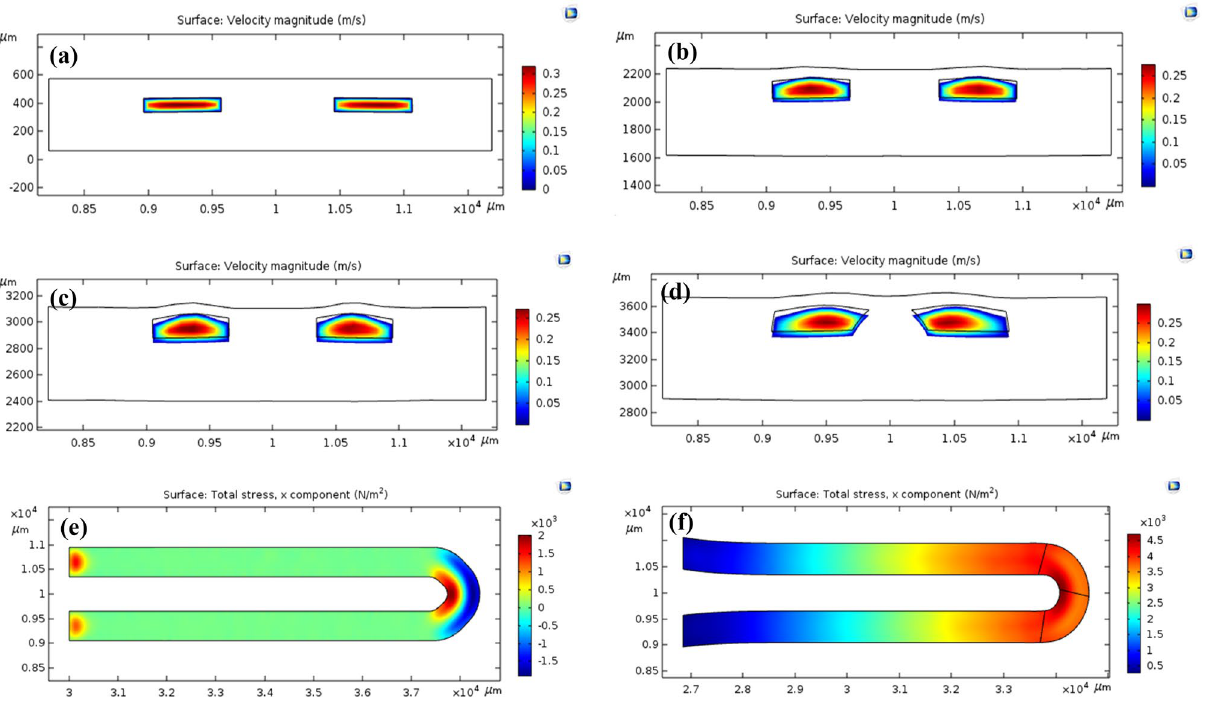
Figure 7. Two-dimensional velocity distribution with an input flow rate of 700 µl/min in a curved layer, longitudinal distance from the origin of coordinates ( a ) 30,000 µm, ( b ) 35,000 µm, ( c ) 36,000 µm and ( d ) 36,500 µm. Distribution of stress applied by fluid to the microchannel wall at the input flow rate of 600 µl/min. ( e ) Straight cantilever, and ( f ) curved cantilever. (COMSOL Multiphysics 5.3, https:// www. comsol.